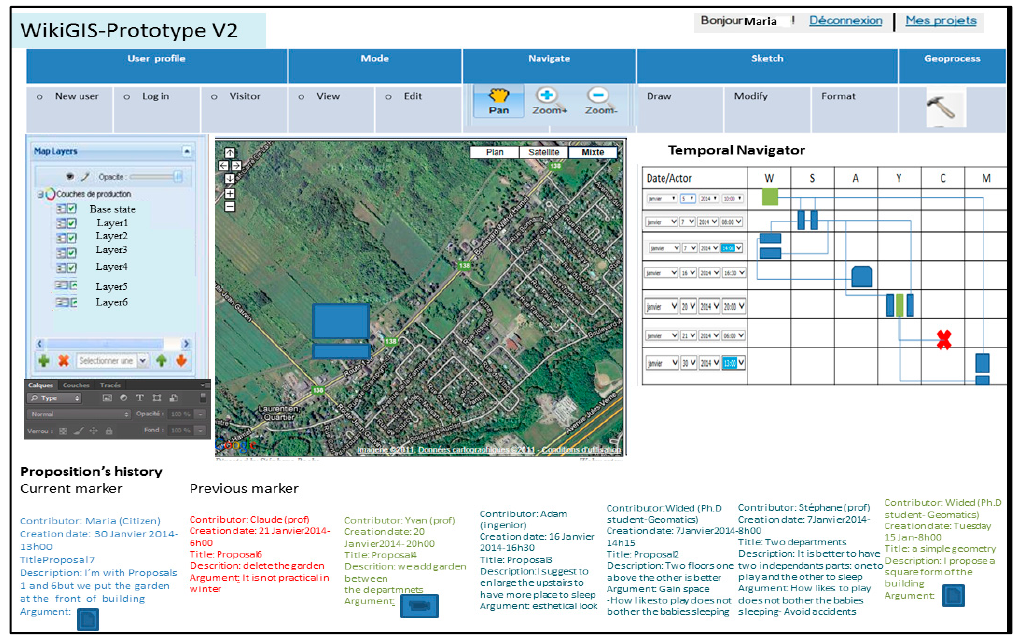
Figure 28. Seventh proposal in the